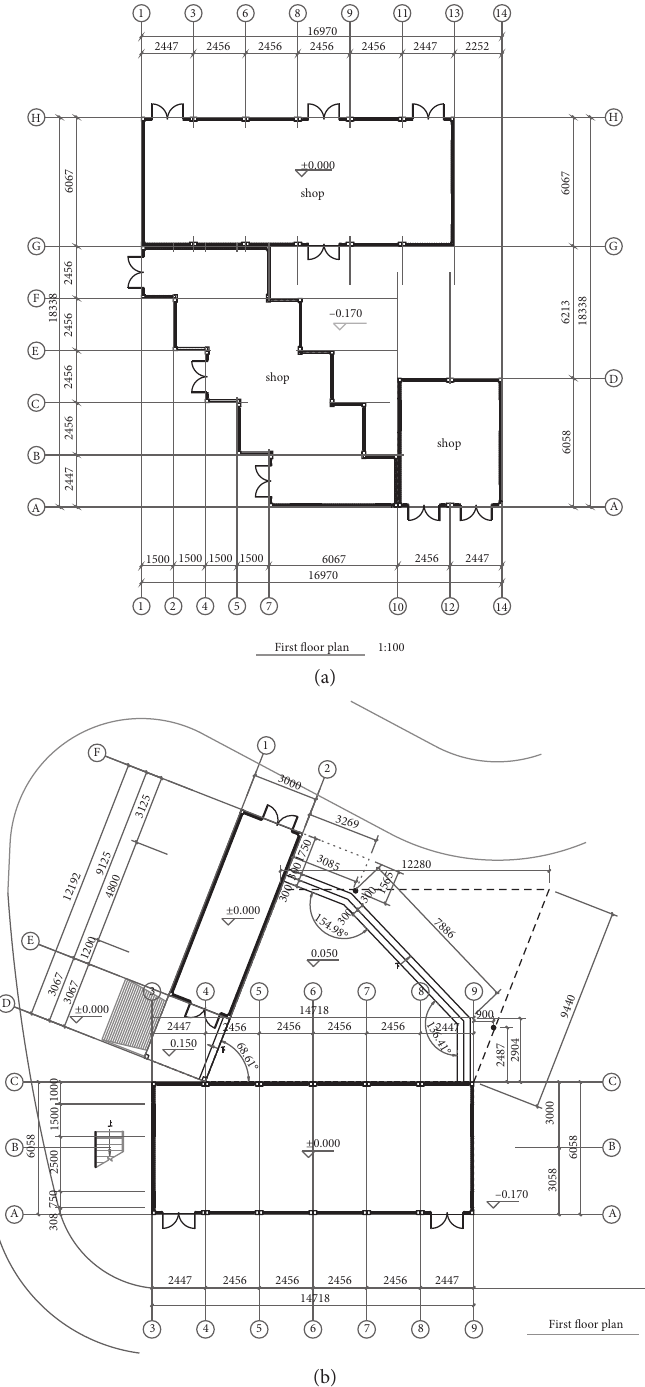
Figure 5: Modular grid plane (Huaduhui Commercial Street). (a) Orthogonal modular grid plane. (b) Oblique modular grid